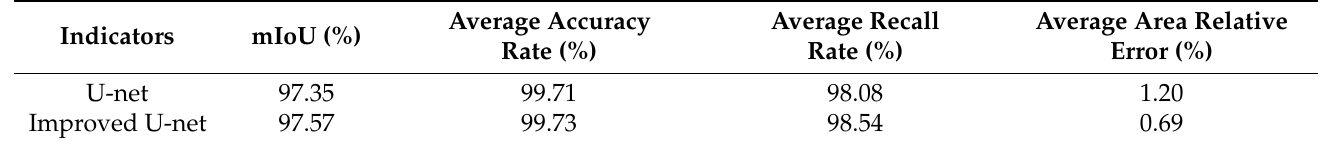
Table 3. Numerical comparison of two networks on four metrics when the fish are tilted.